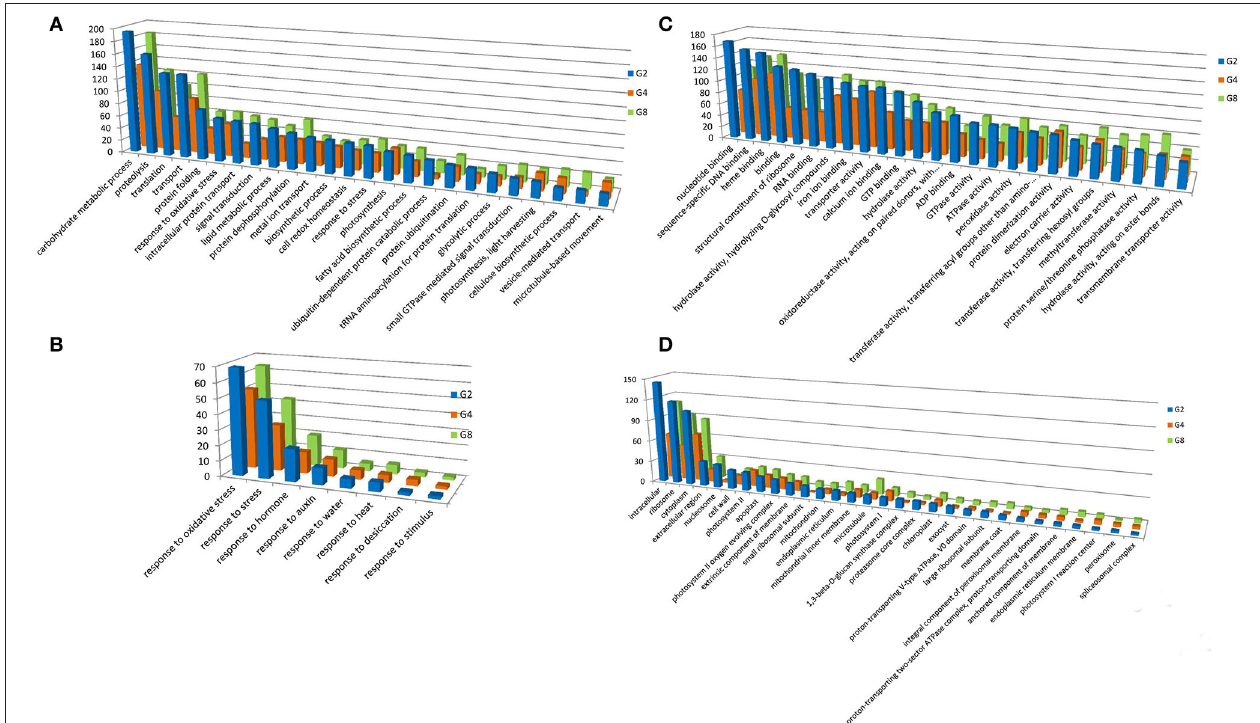
FIGURE 2 | Gene ontology (GO) terms with predominant DEG number under dehydration treatment. GO terms of BP (A) , MF (C) , and CC (D) were shown. (B) Indicates GO terms of MF, which are closely related to stress responses. Y-axis indicated the DEG number assigned in a GO term. CK, control; G2, G4, and G8 indicated 2h, 4h, and 8h of dehydration treatment,